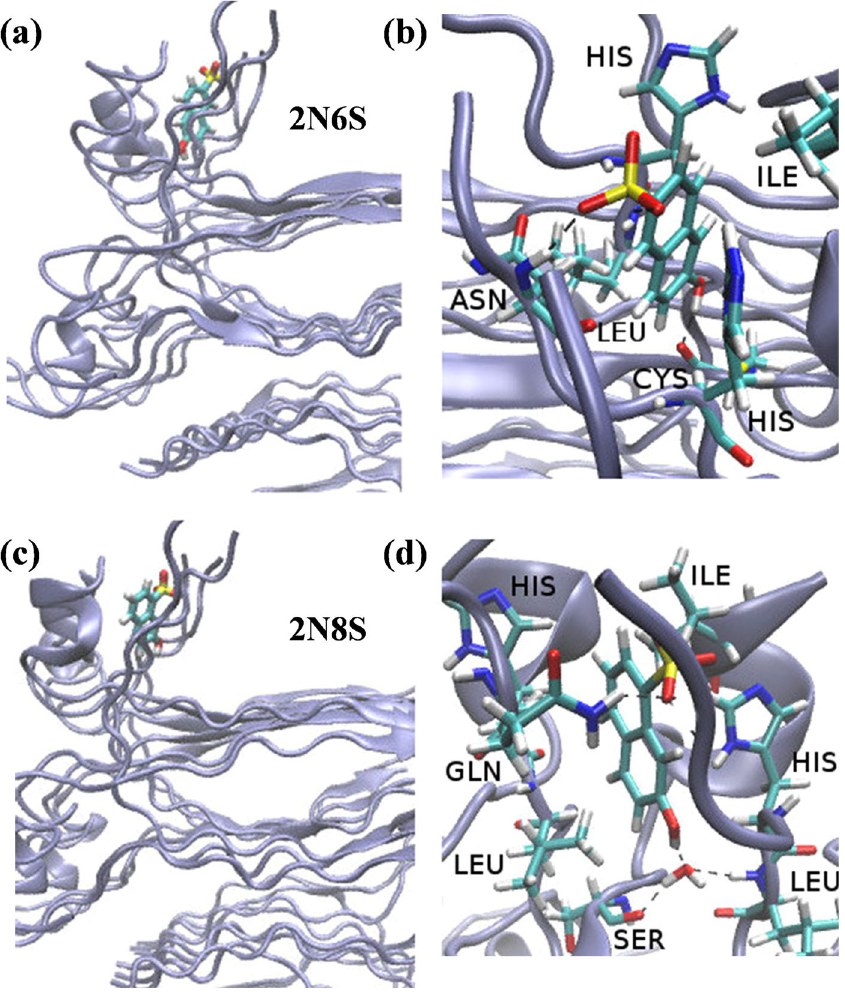
Figure 5. A bird’s-eye view of ( a ) 2N6S and ( c ) 2N8S bound to binding site 2 on the insulin fibril surface. ( b and d ) Close-up view of ( a ) and ( c ),